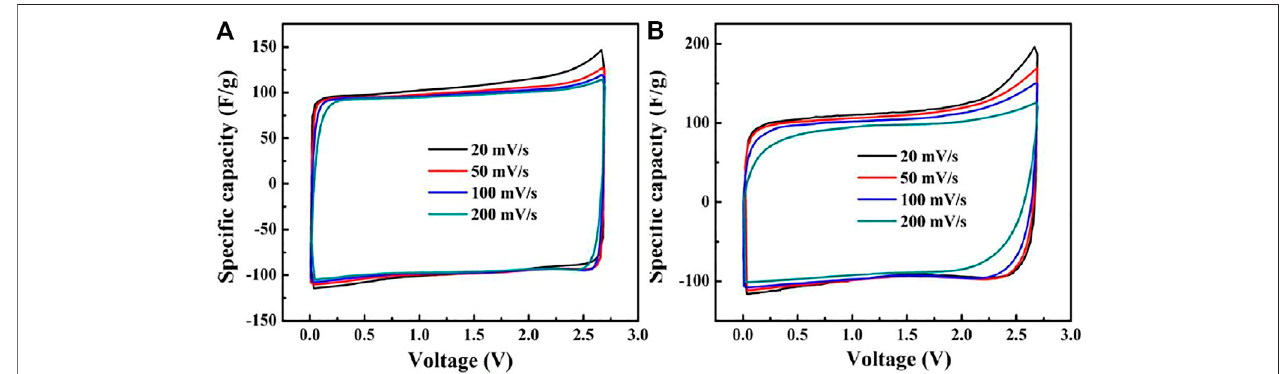
FIGURE 3 | The CV curves of Ni-AC (A) and AC (B) in different scan